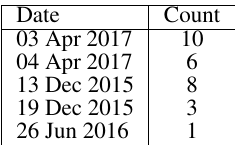
Figure 1. Intersection of union